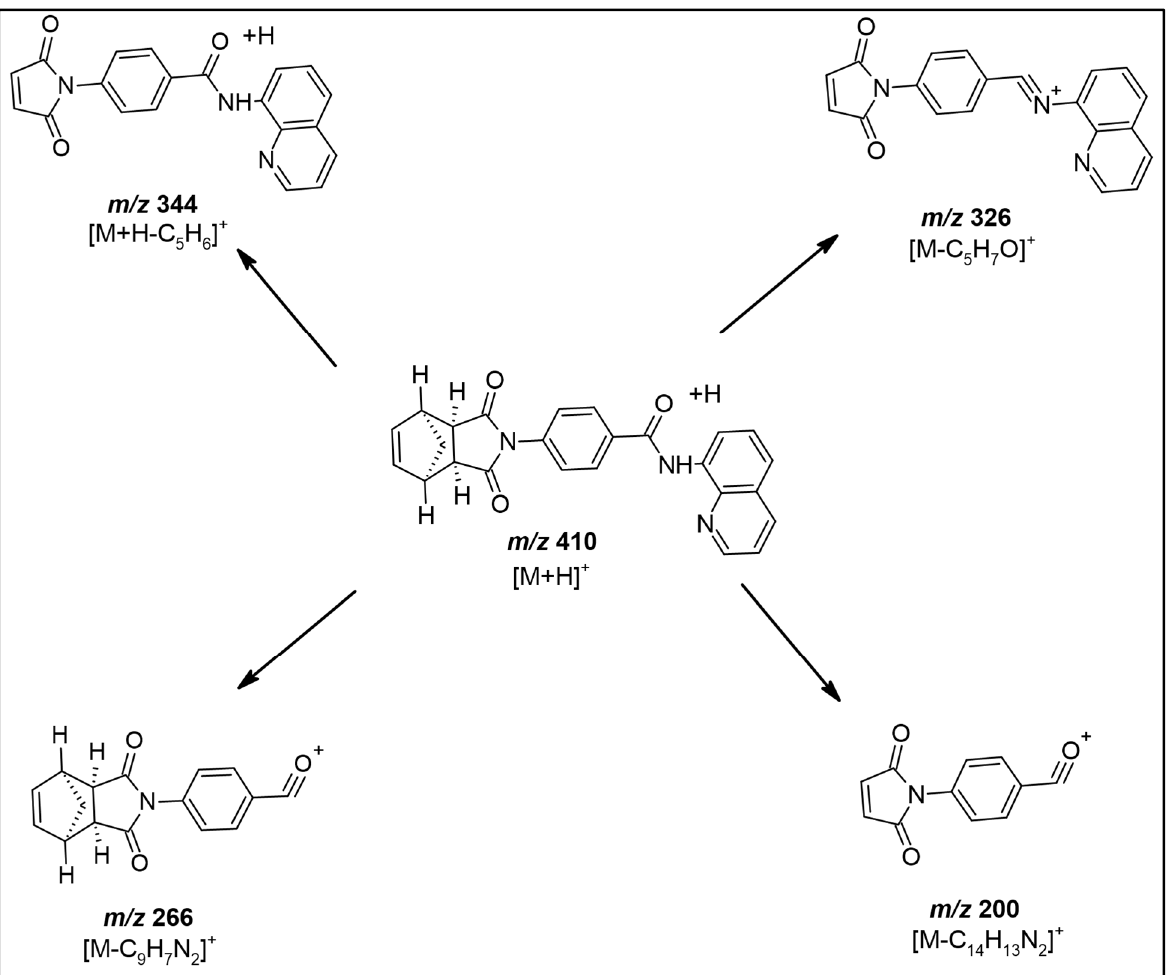
Figure 3. Proposed fragmentation pattern for the prominent product ions of IWR-1-endo.